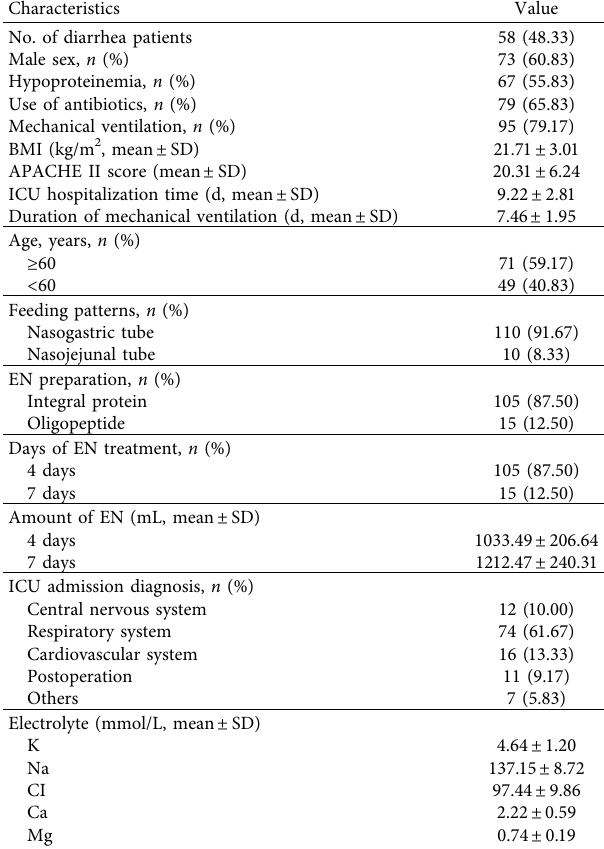
Table 1: Clinical characteristic of patients.